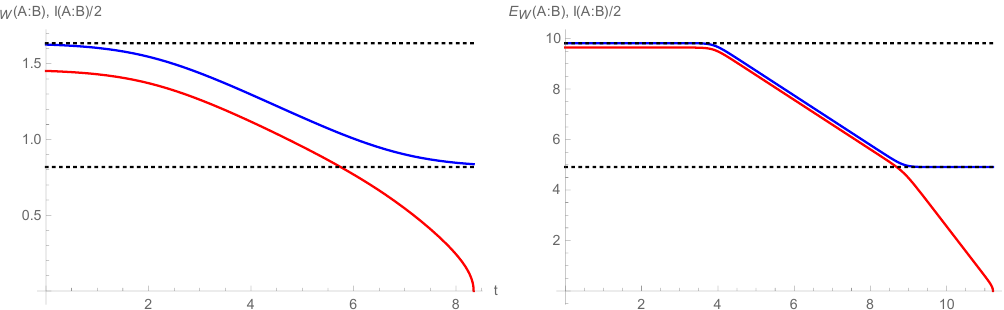
Figure 3 . Half of the mutual information (red) and the entanglement wedge cross-section (blue) for localized shock wave for two di(cid:11)erent temperatures, with t denoting the time in the past of the shock insertion. After the red line reaches zero, the entanglement wedge becomes disconnected and the blue line jumps to zero. In the above plots we took x = 1, x A = 5, x B = 10. The dotted lines correspond to values s eq L and s eq L= 2 respectively. For high enough temperatures (right plot) an interesting plateau develops in the late time region, which should be properly captured by our setup. For low temperatures (left plot) mutual information disappears before we enter our region of validity, we therefore expect that there might be some corrections to the above